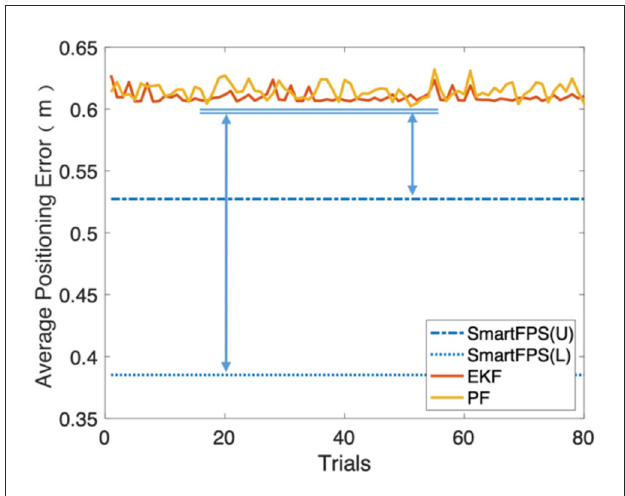
FIGURE9 Gap between the positioning errors of filter methods and SmartFPS.